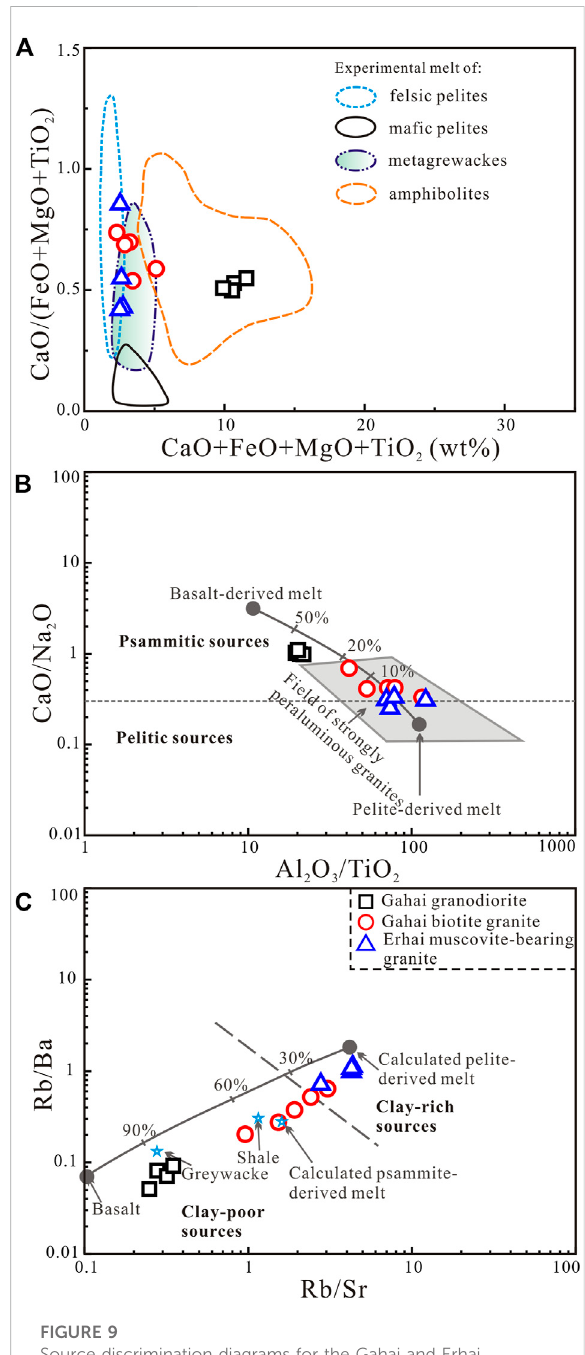
FIGURE 9 Source discrimination diagrams for the Gahai and Erhai granitoids (A) CaO + FeO + MgO + TiO 2 vs. CaO/(FeO + MgO + TiO 2 ) diagram (modi fi ed after Patiño Douce, 1999); (B) Al 2 O 3 /TiO 2 vs. CaO/Na 2 O diagram (modi fi ed after Sylvester, 1998); (C) Rb/Sr vs. Rb/Ba diagram (modi fi ed after Sylvester,